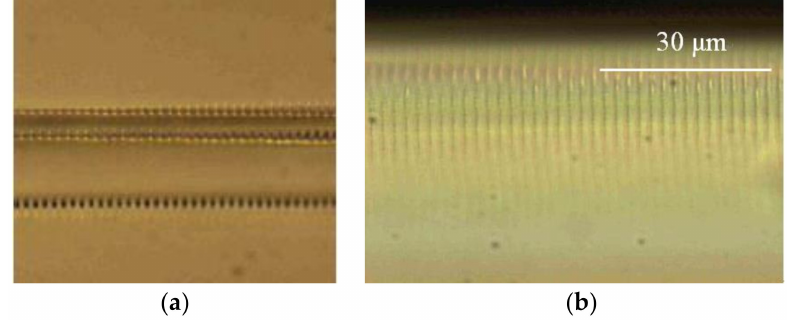
Figure 2. Microscopic image of FBG written by ( a ) PbP femtosecond laser; and ( b ) LbL femtosecond laser